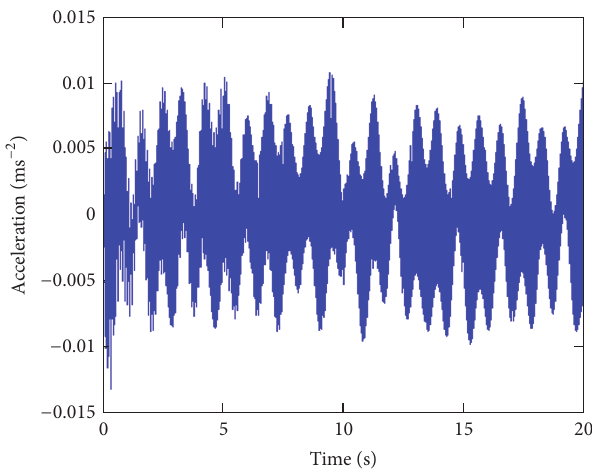
Figure 6: The midspan acceleration response of undamaged beam with mass velocity for